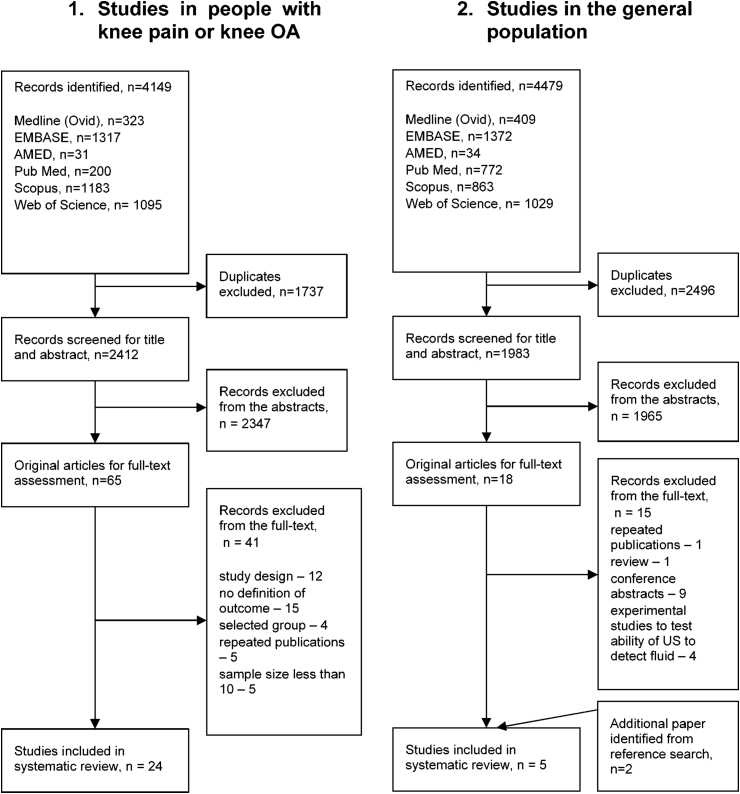
Study selections.